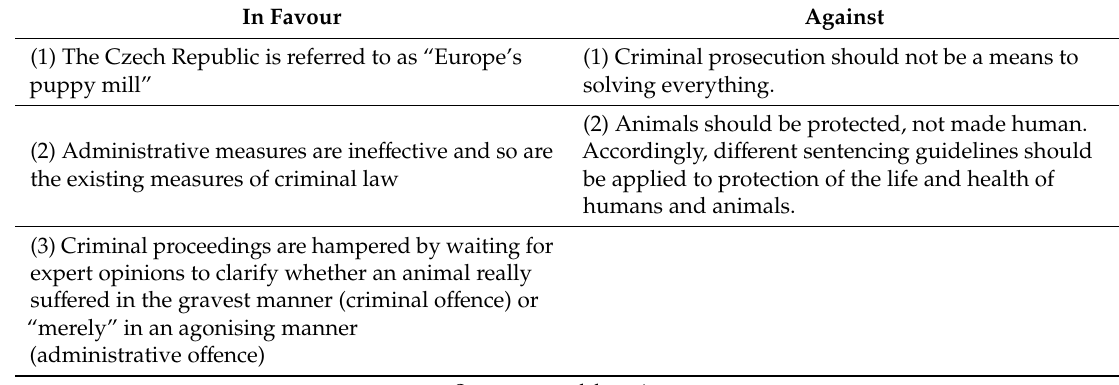
Table 2. Arguments in favour of and against tougher penalties for animal abuse and deficient puppy